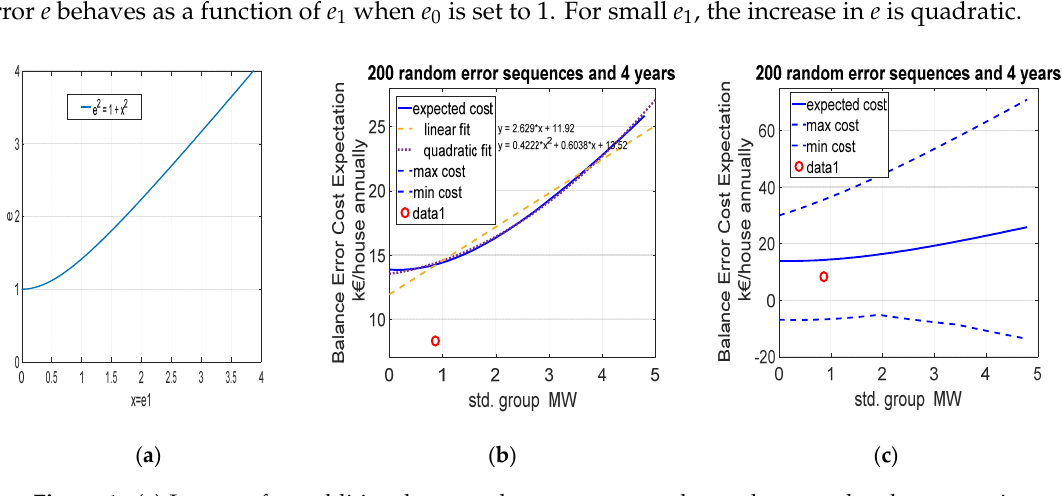
Figure 1. ( a ) Impact of an additional error std. component to the total error std. when assuming normally distributed independent error sequences, ( b ) the behavior of the mean of simulated balancing error costs, ( c ) the range of balancing error cost variation in the simulations.